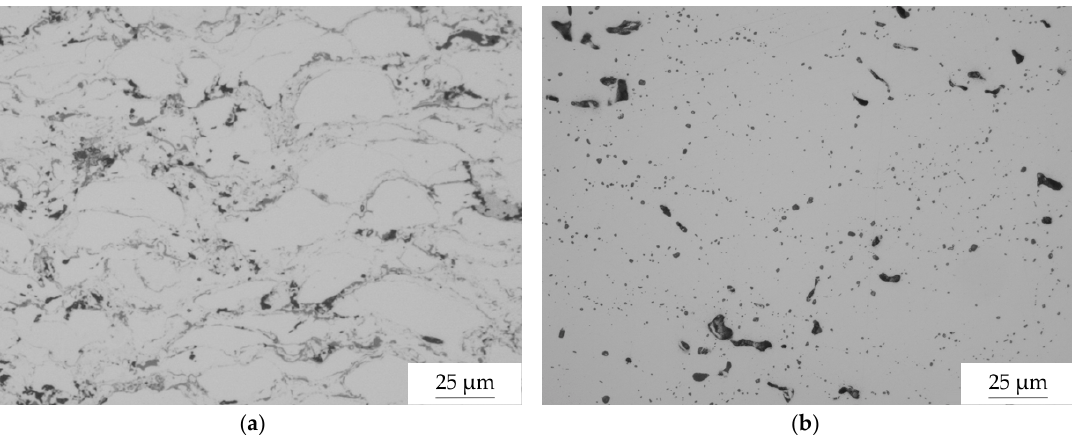
Figure 1. Optical-microscopic images of the AISI 316L HVOF coating in cross-section ( a ) as-sprayed